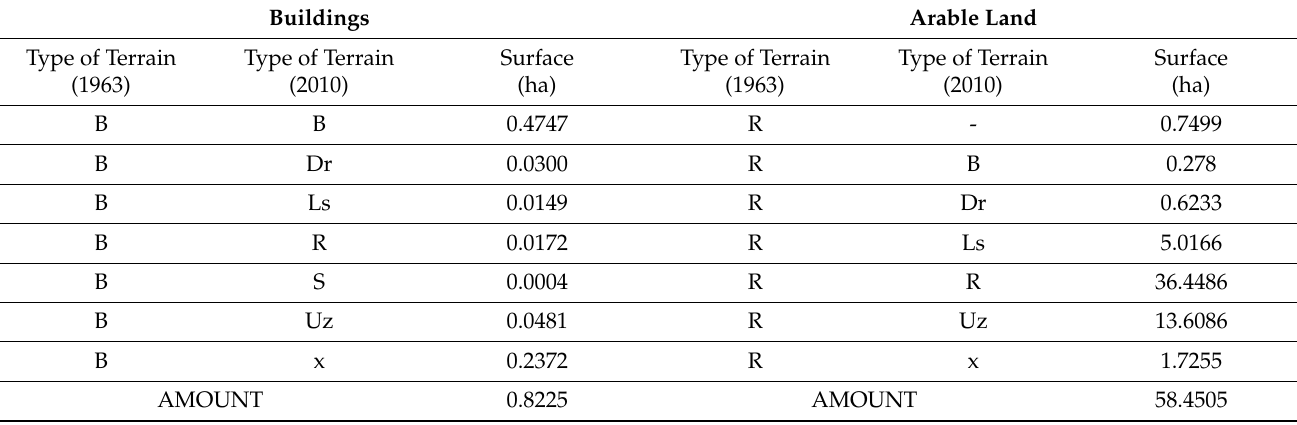
Table 4. The list of landscape changes in individual